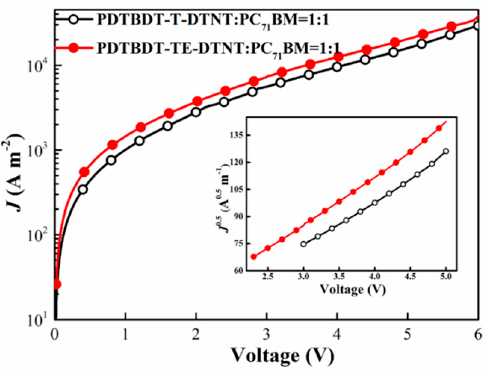
Figure 5. J-V and J 0.5 -V characteristics of the blend films from copolymers in the hole-only devices with configuration of ITO/PEDOT:PSS/polymer:PC 71 BM/MoO 3 /Ag.